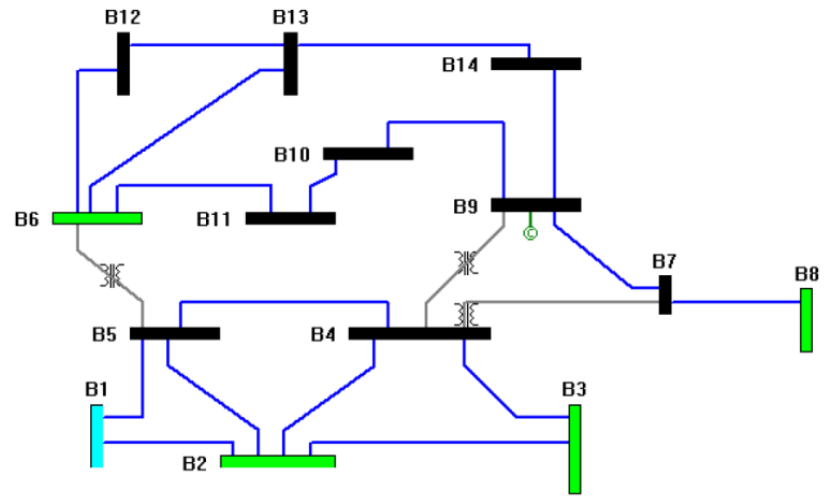
Figure 3. IEEE 14-bus system.